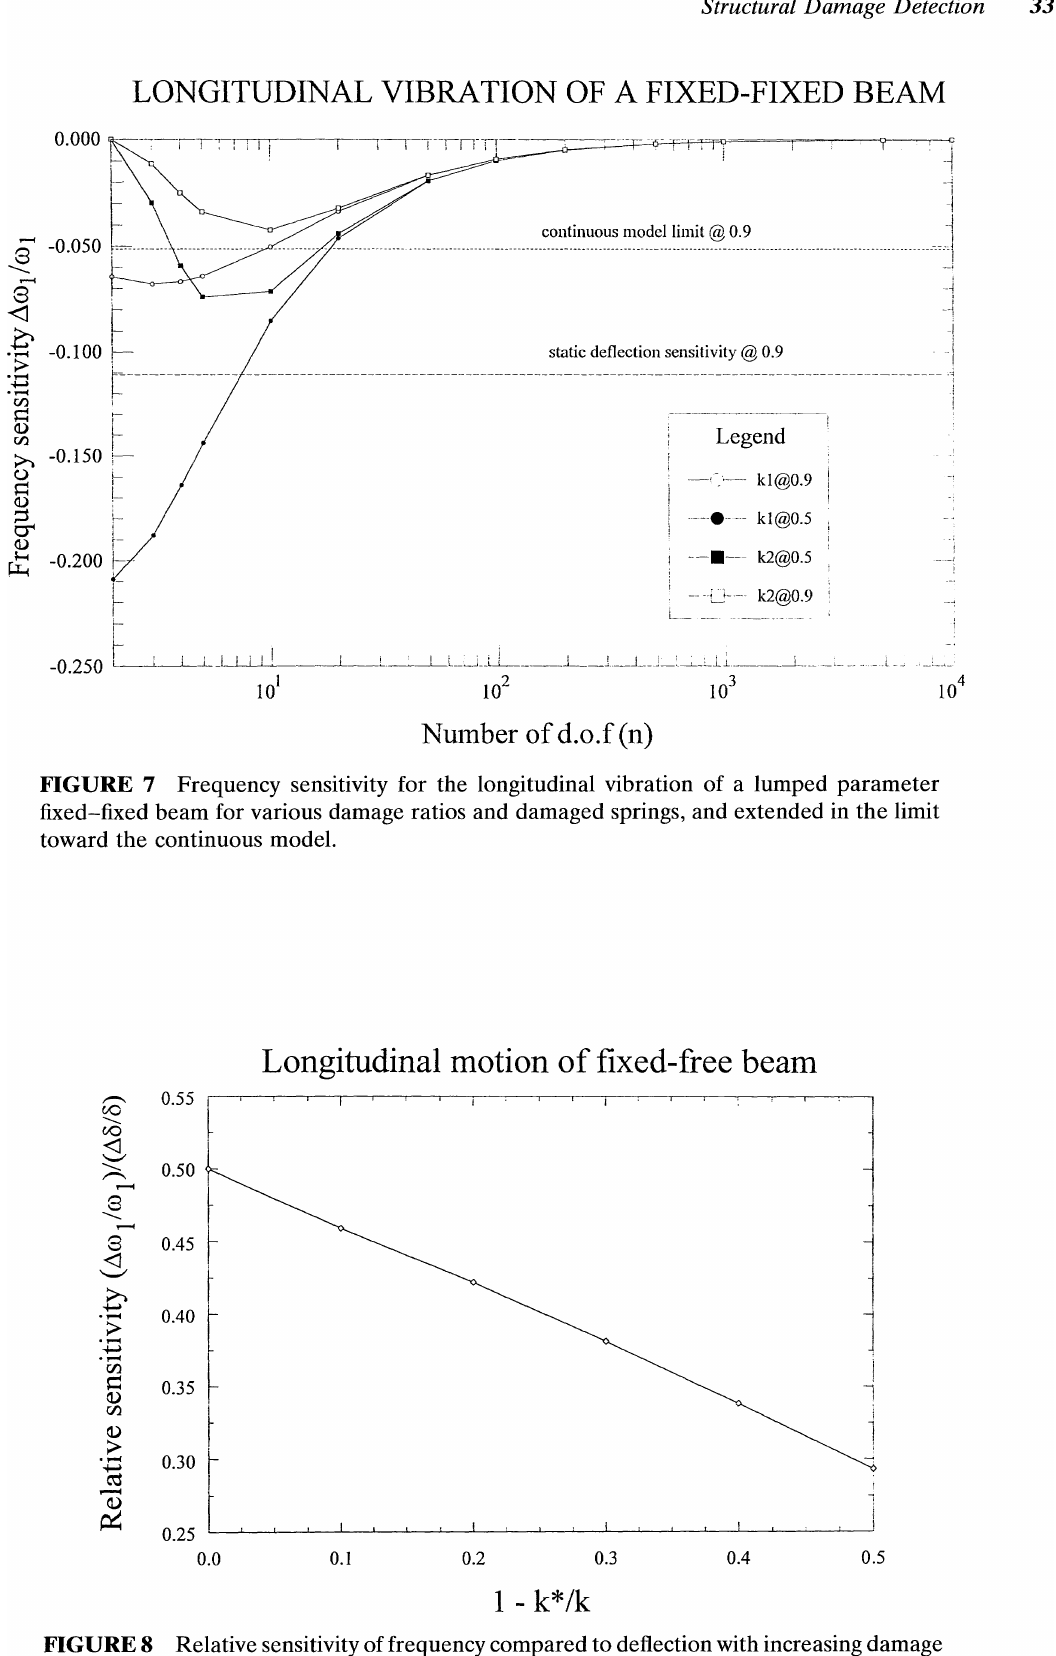
FIGURE 8 Relative sensitivity of frequency compared to deflection with increasing damage for the longitudinal motion of a fixed-free